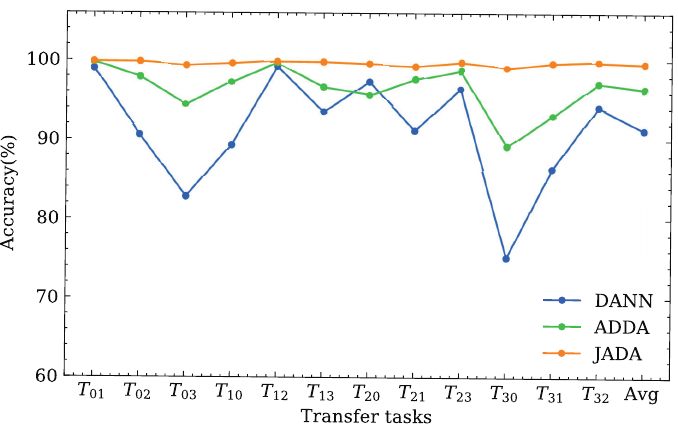
Figure 10. Classification accuracies of the different methods for the CWRU